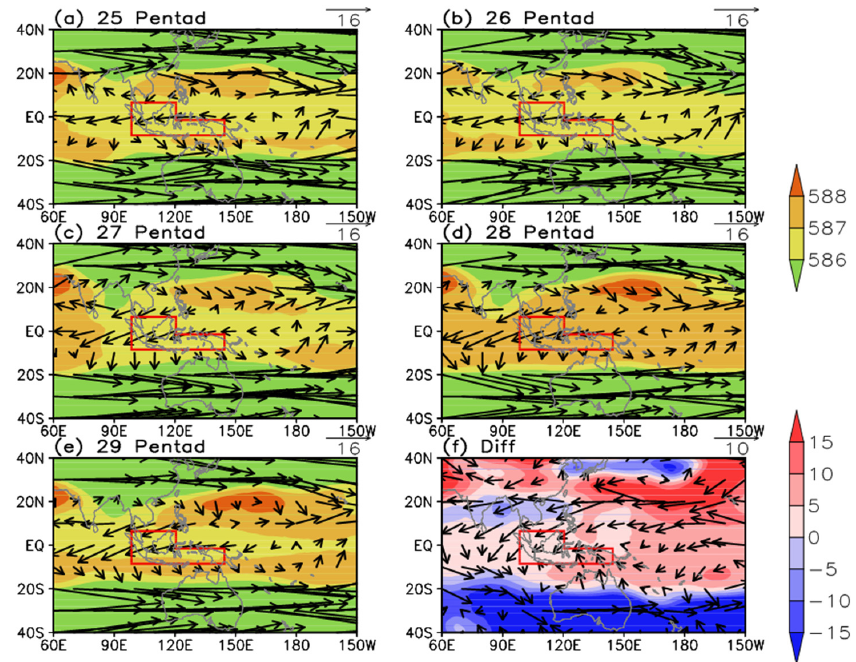
Figure 4. Same as in Figure 3, but for 500-hPa geopotential height (CFSR; dgpm; shading) and 200-hPa winds (CFSR; m/s; vectors).